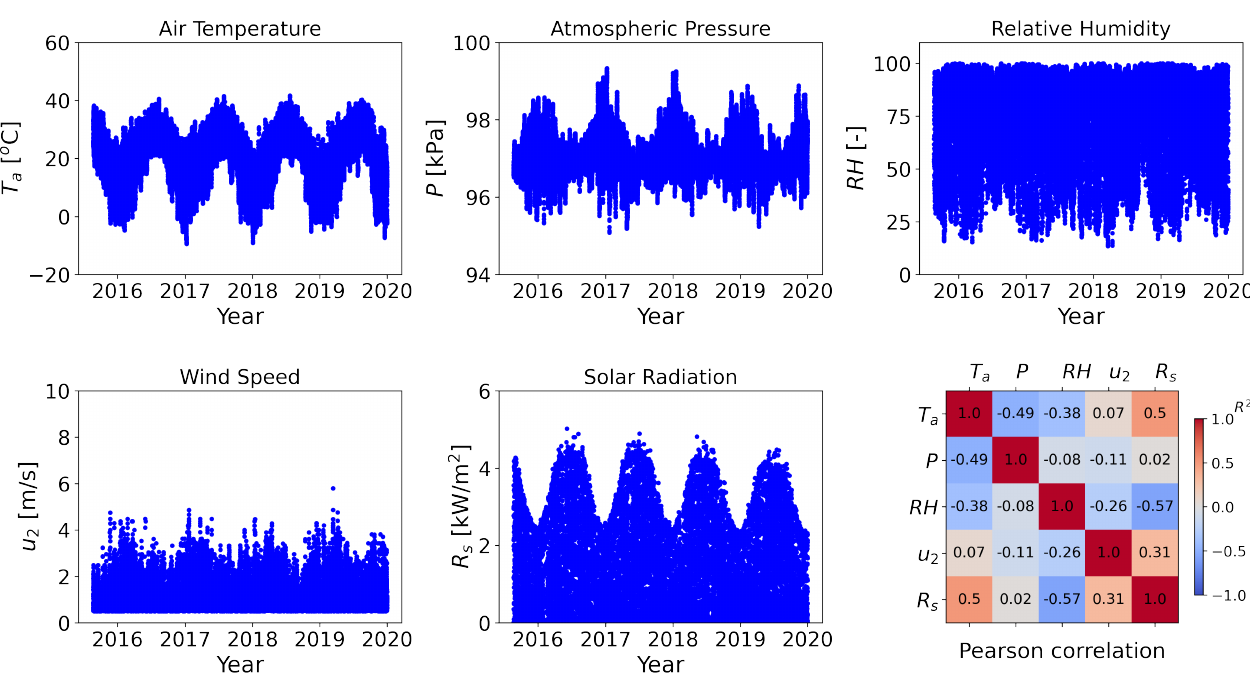
Figure A2. Hourly climate data and statistical correlations among them at the BCRAGD weather station.